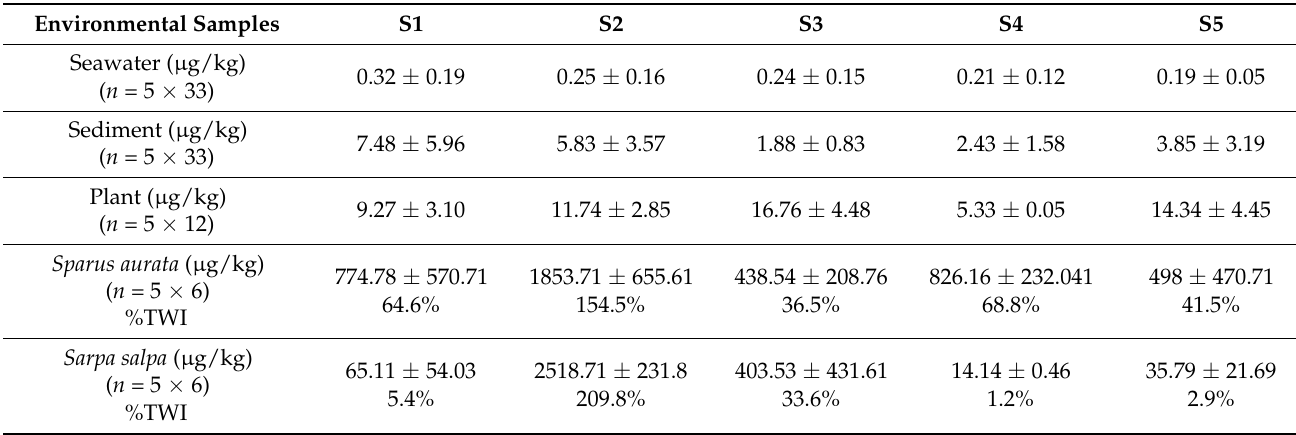
Table 1. Hg concentrations ( µ g/kg), standard deviation, mean values in environmental samples (seawater, sediment, Posidonia oceanica leaves, Sparus aurata muscle tissues and Salpa sarpa muscle tissue) and TWI% for Hg contents in Sparus aurata and Sarpa salpa